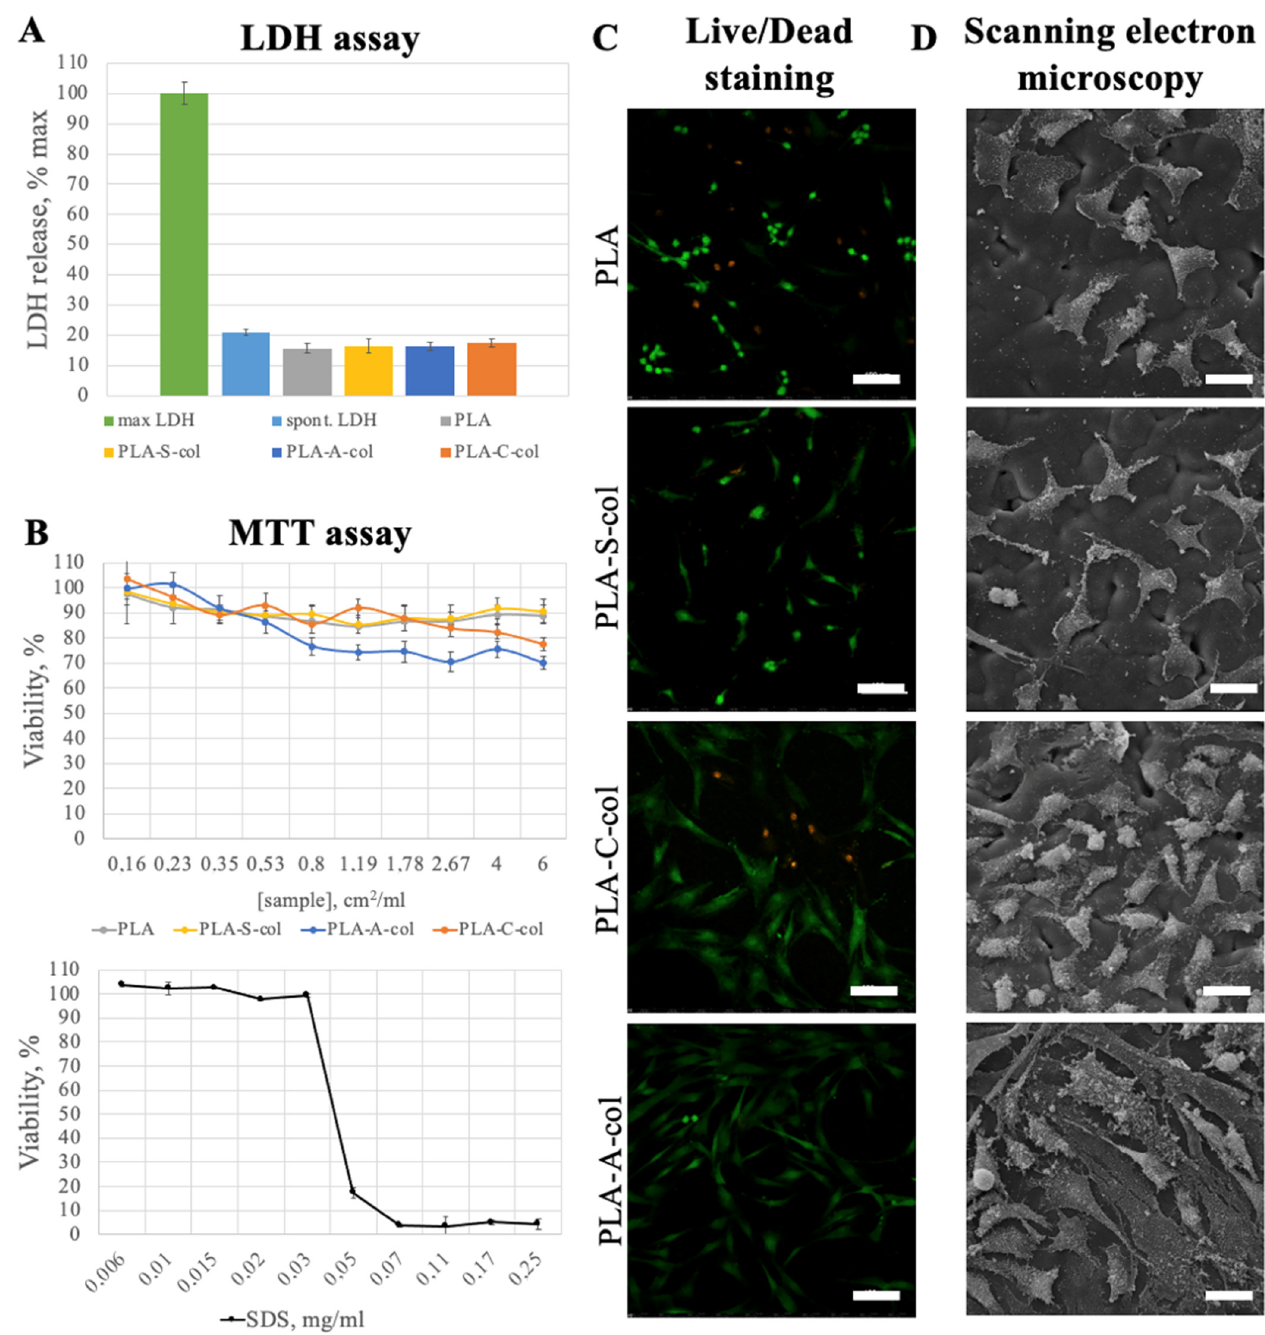
Figure 6. Cell adhesion and cytotoxicity results: ( A ) LDH assay (spontaneous LDH release (spont. LDH) and maximum LDH release (max LDH) were used as a control); ( B ) MTT assay (SDS was a positive control); ( C ) Live/Dead staining of 3T3 cells seeded on the PLA films (merged, calcein AM (green)—live cells, propidium iodide (red)—dead cells), 3 days of cultivation, laser scanning confocal microscopy, scale bar is 100 μ m; ( D ) hMSCs seeded on the PLA films, 3 days of cultivation, scanning electron microscopy, scale bar is 30 μ m.